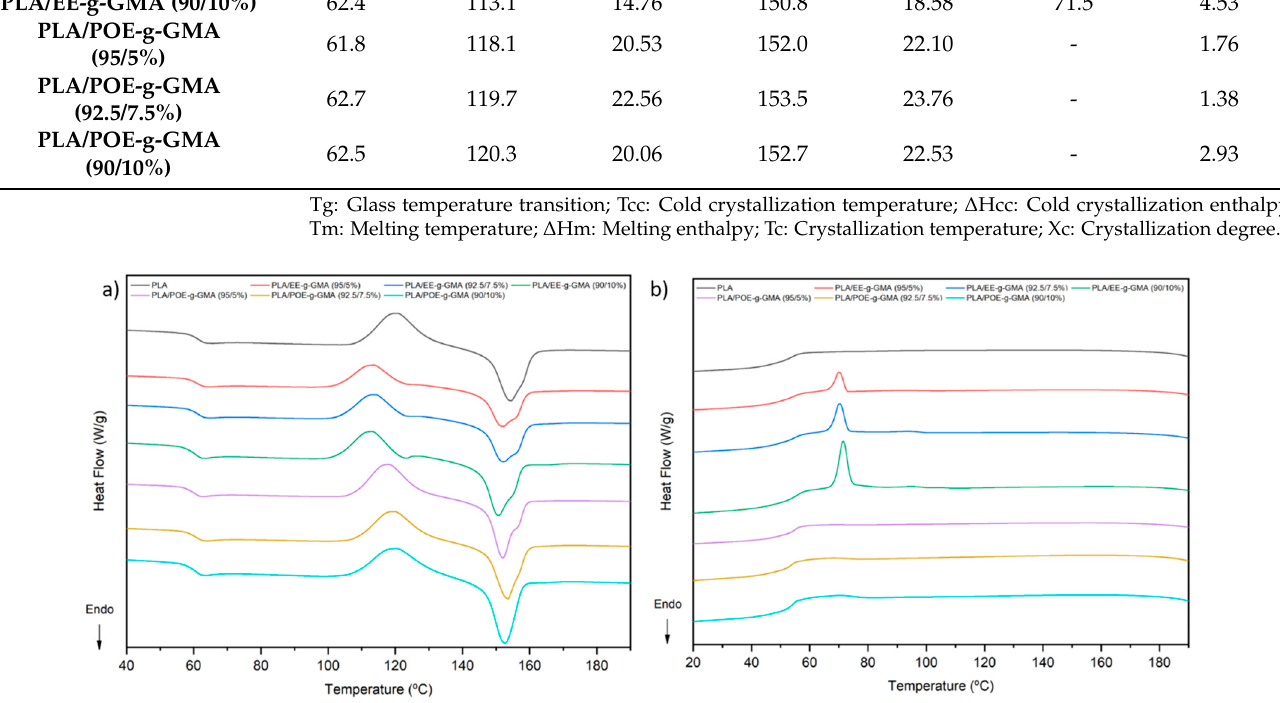
2.93 Tg: Glass temperature transition; Tcc: Cold crystallization temperature; Δ Hcc: Cold crystallization enthalpy; Tm: Melting temperature; Δ Hm: Melting enthalpy; Tc: Crystallization temperature; Xc: Crystallization degree.